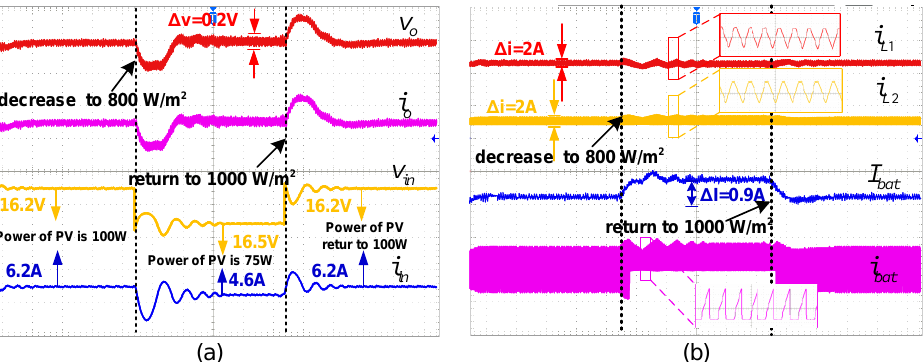
Figure 10. Dynamic waveforms of ( a ) v in , i in , v o , and i o , and ( b ) i L 1 , i L 2 , I bat , and i bat during input